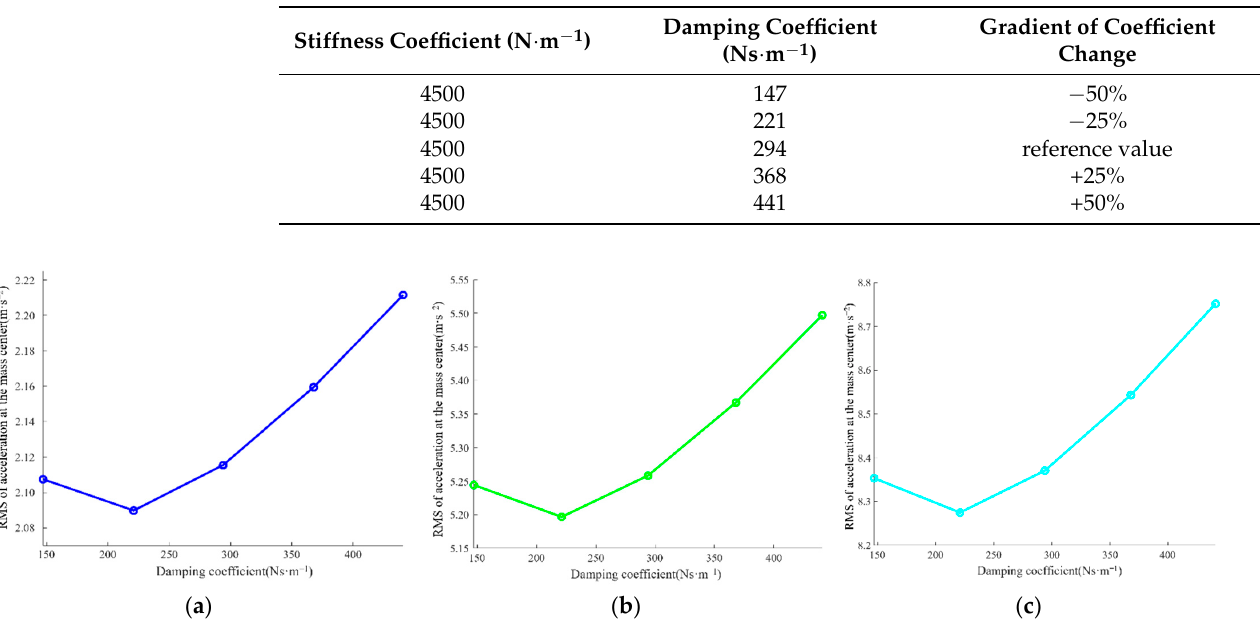
Table 3. Simulation parameters of stiffness value for large heave motion.